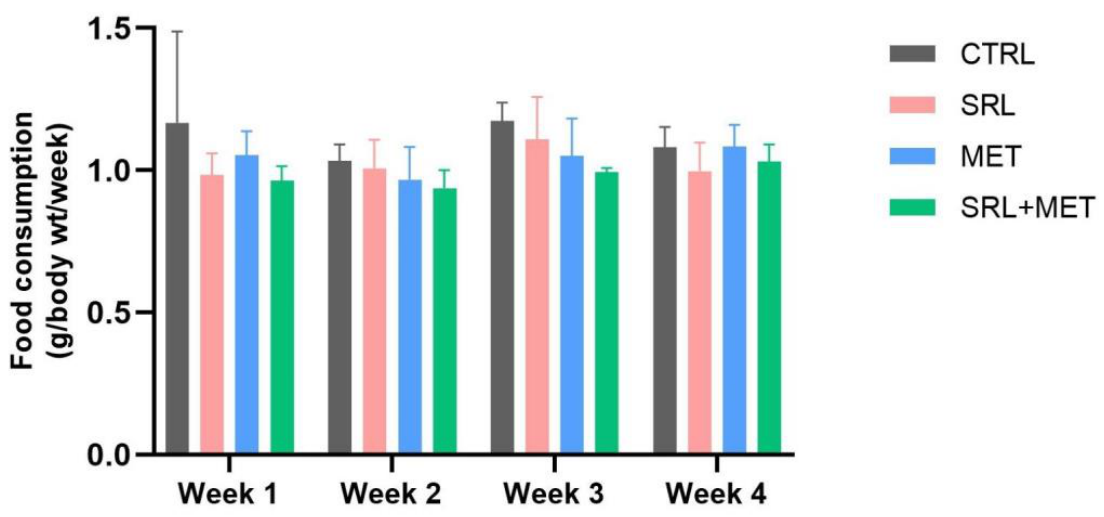
Figure 2. Weekly food intake (g/g body weight/week), in Control, MET alone, SRL alone, and MET-